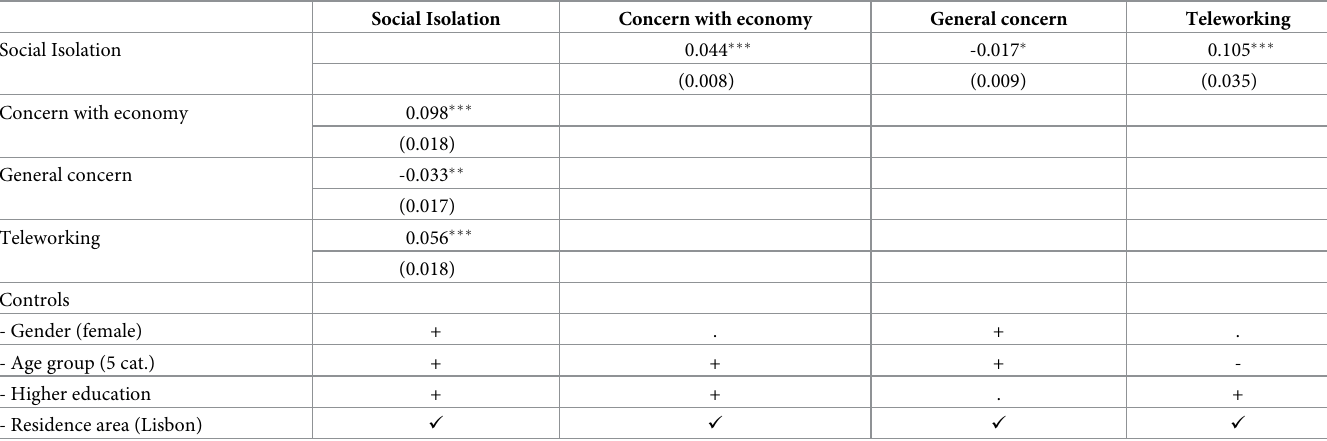
Table 4. Probit (margins) results for social isolation, concerns, and